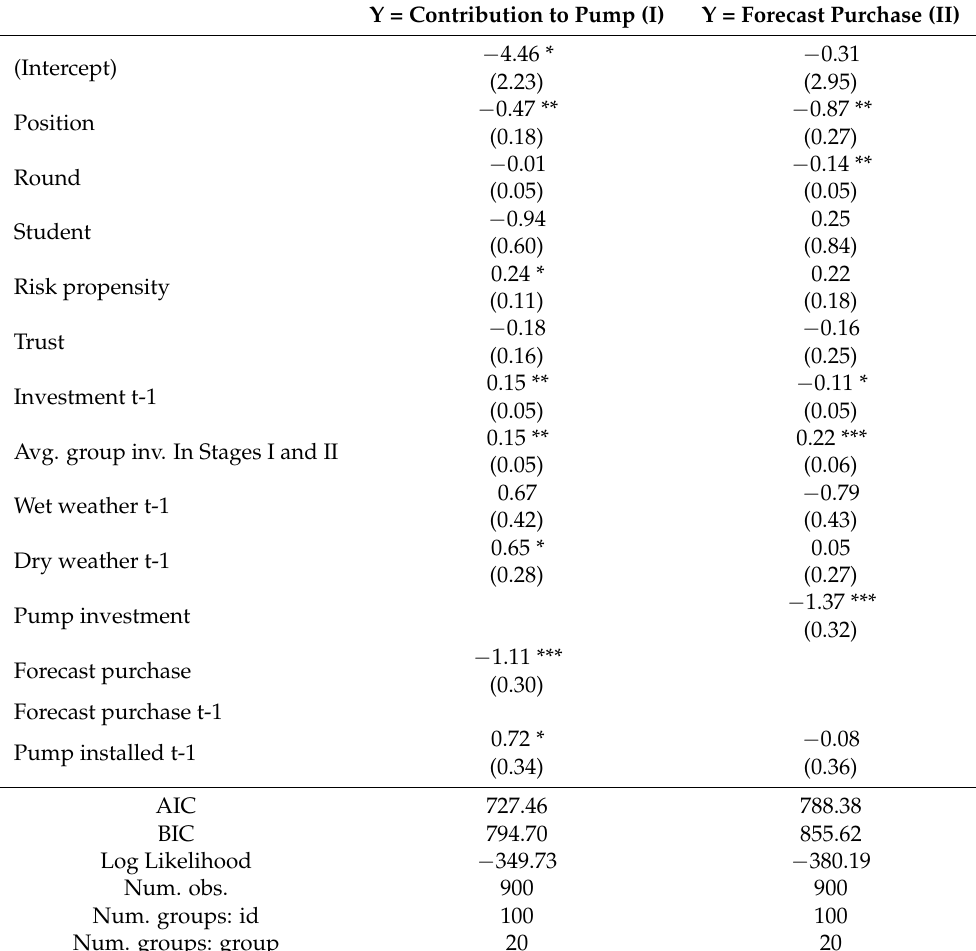
Table 5. Individual investments in adaptation